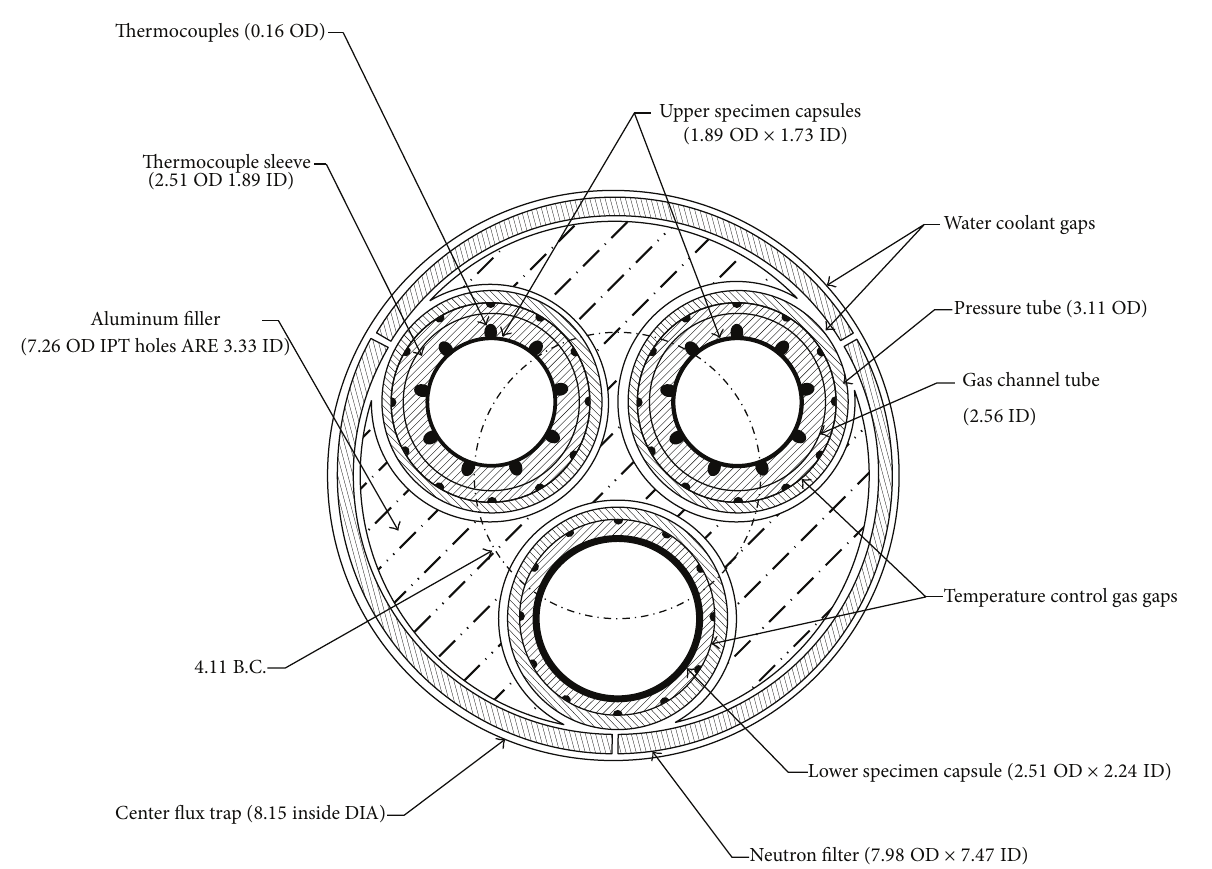
Figure 20: Core region ITV cross-section without specimens